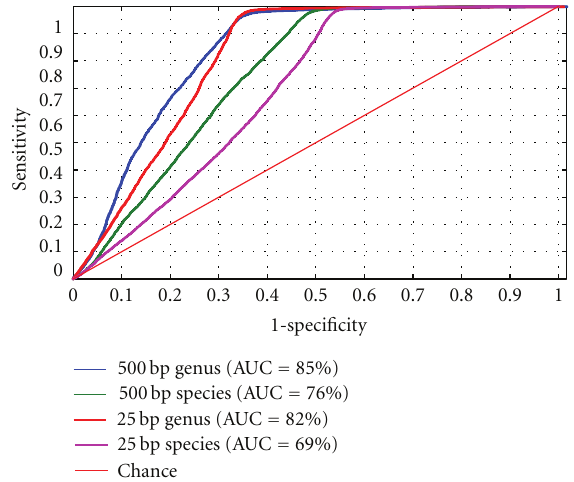
Figure 4: The PhymmBL ROCs follow a similar shape to the BLAST ROCs but have significantly better optimal operating points. Yet, the overall AUC of each of the curves falls below that of NBC